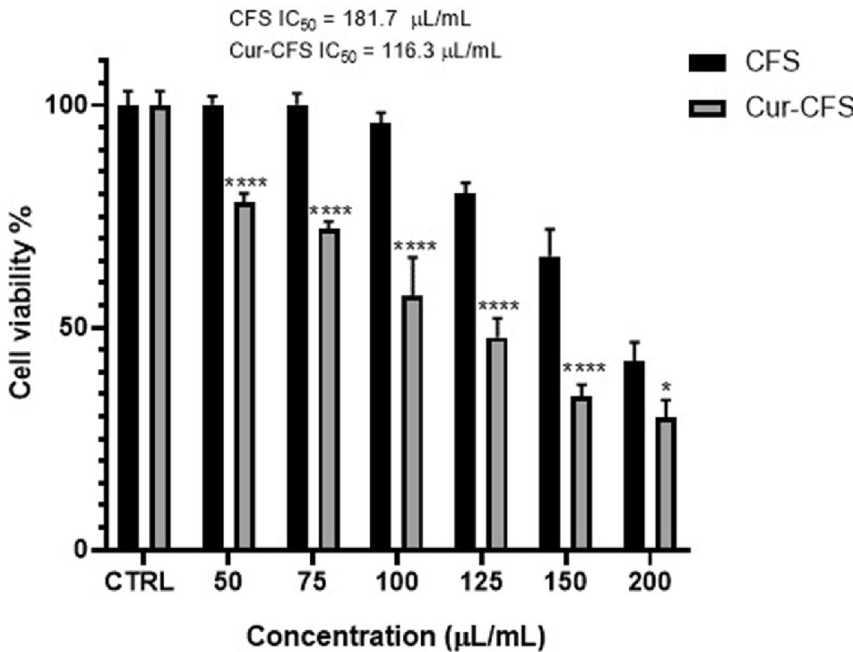
Figure 3. The effect of different concentrations of CFS and cur-CFS on the viability of HT-29 cells after 24 h. (**** p ˂ 0.0001) (* p <